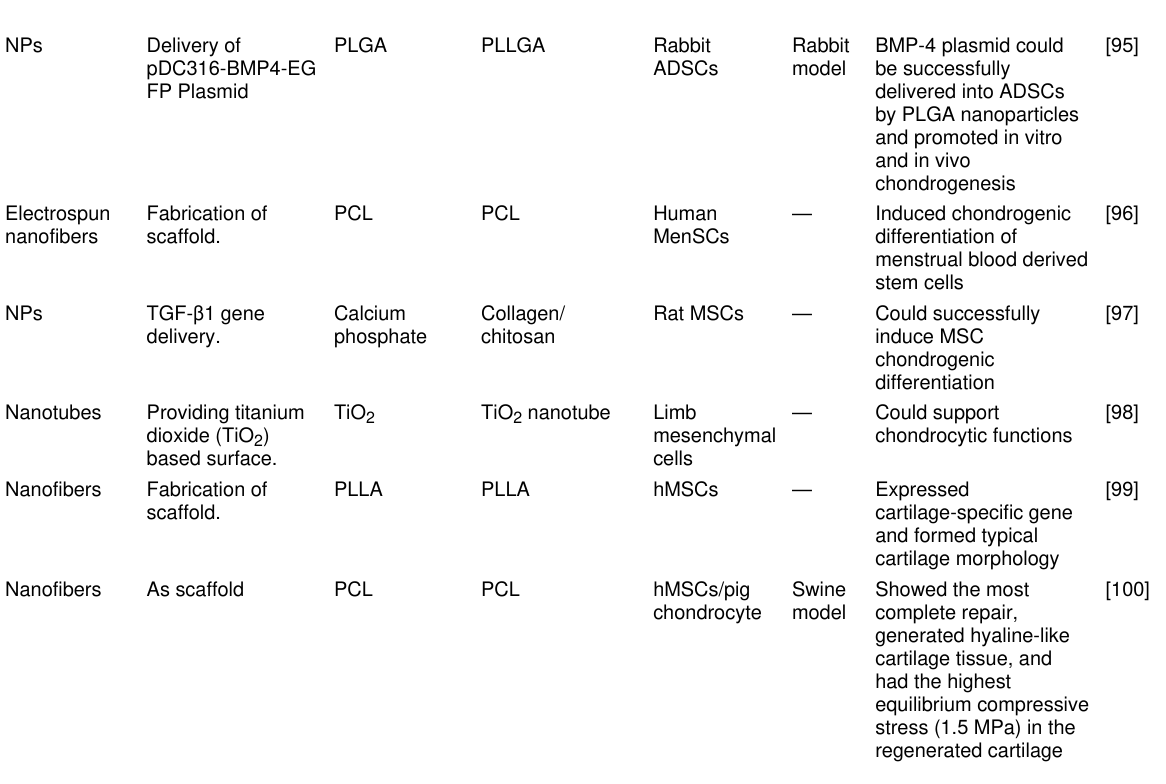
Table 1: Summary of the recent studies on microscale/nanoscale materials used for the fabrication of cartilage tissue engineering (TE) structures. (continued)